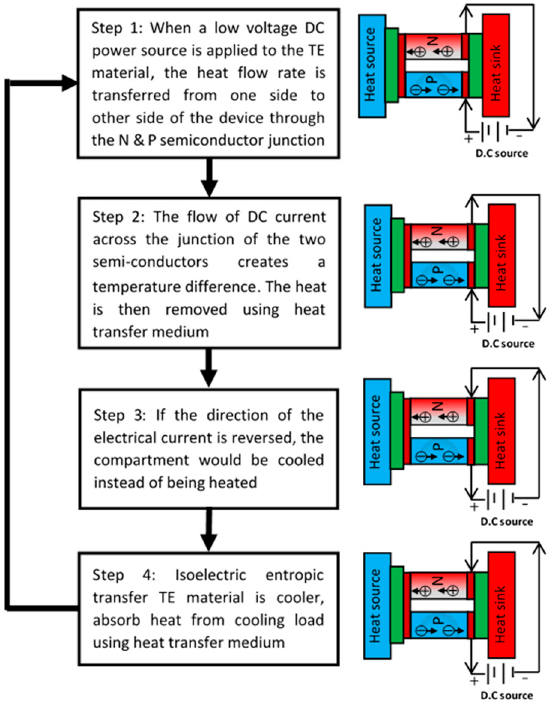
Figure 3. Schematics showing the basic working principle of thermoelectric Refrigeration.